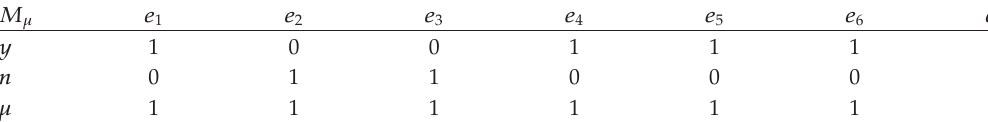
Table 4: Model GIVFSS for dengue fever.